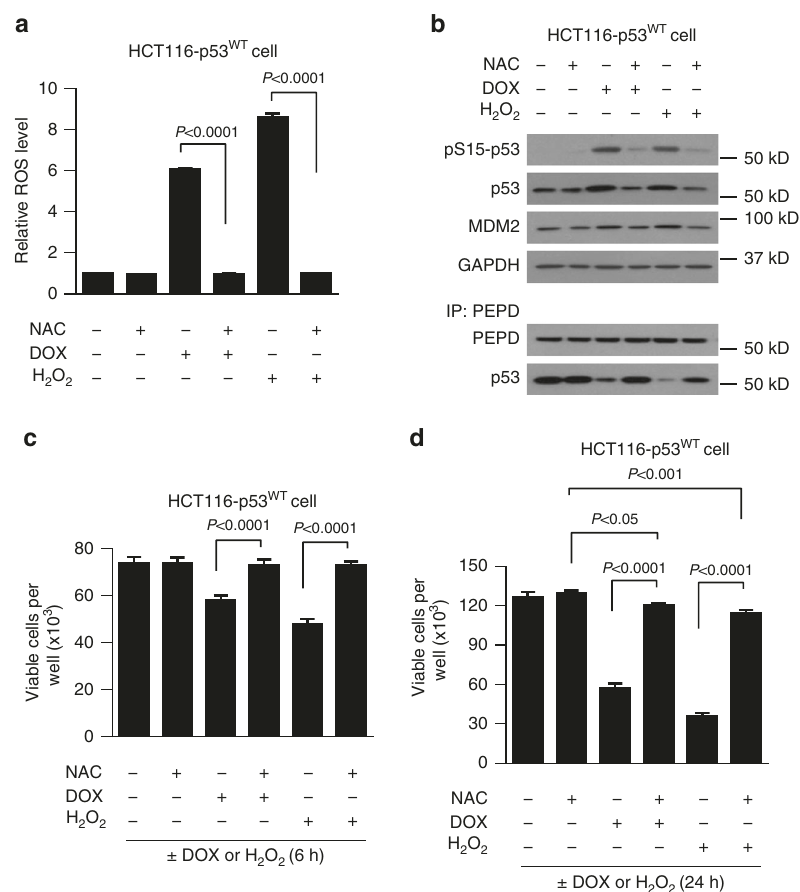
Fig. 9 ROS is key to stress-induced p53 liberation from PEPD. a Relative ROS level in cells treated with solvent, DOX or H 2 O 2 for 6 h, with or without NAC pretreatment for 3 h. b IB and IP-IB analysis of various proteins in cells treated with solvent, DOX or H 2 O 2 for 6 h, with or without NAC pretreatment for 3 h. GAPDH was measured as a loading control. c , d Measurement of cell viability after treatment with DOX or H 2 O 2 for 6 h or 24 h, with or without NAC pretreatment for 3 h. Data are means ± s.d. ( n – 3); two-way ANOVA followed by Tukey multiple comparisons test. In all experiments, cells were cultured in 12-well plates (4 × 10 4 cells/well) for 24 h before experimental treatment. DOX, H 2 O 2 and NAC were used at 400 nM, 400 μ M and 5 mM,